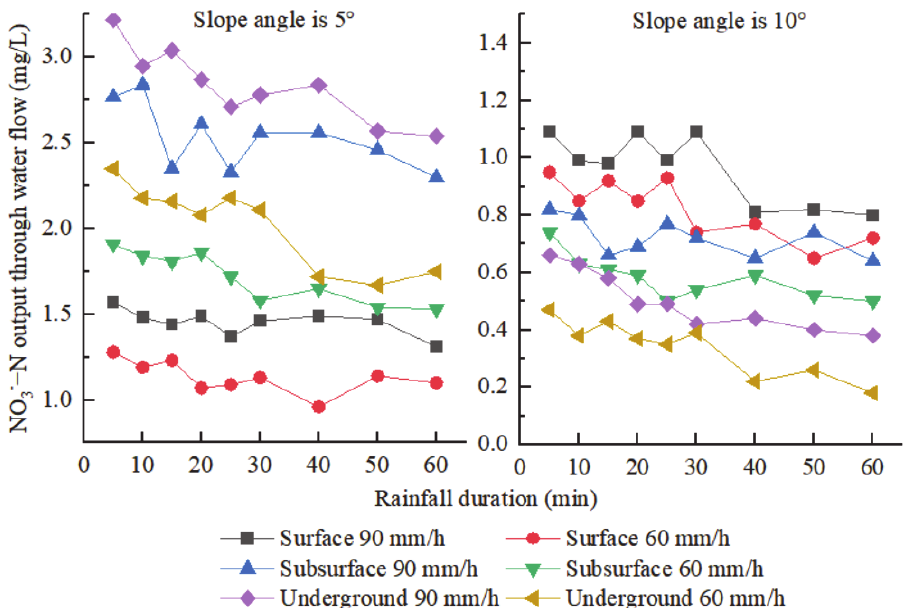
Figure 6. Variation of nitrate ‐ nitrogen output concentration through water flow in Karst slope farmland with time.